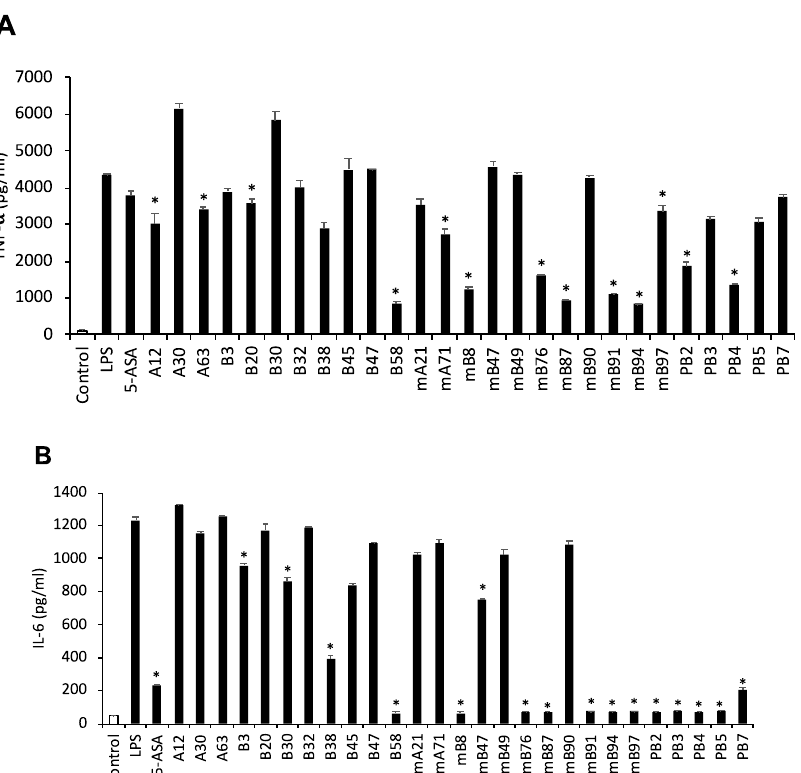
Figure 1. Effect of selected 27 samples on TNF- α and IL-6 production in LPS-stimulated RAW264.7 cells. RAW264.7 cells (3 × 10 5 cells/well, 24-well plate) were first treated with LPS (1 μ g/mL) for 1 h